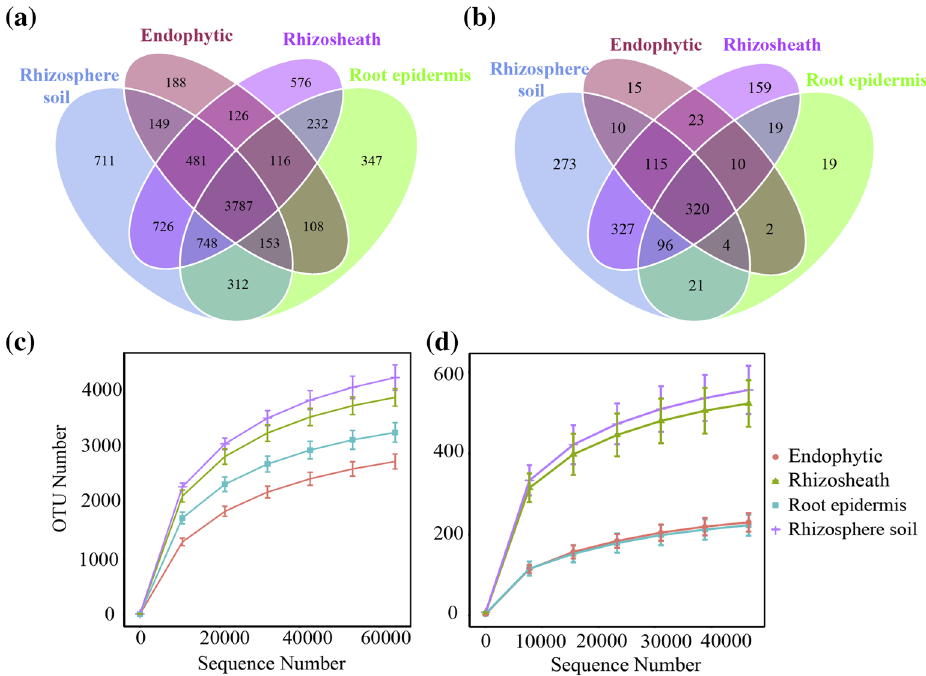
Figure 3. Venn diagrams of samples and rarefaction curves for samples. In ( a ) and ( c ) are bacteria, and ( b ) and ( d ) are fungi. In ( a , b ), each circle in the Venn diagram represents a group of samples. The numbers in the overlapping areas represent the number of OTUs shared between groups, and the numbers in areas without overlap represent the number of OTUs unique to the sample group. In ( c , d ), the abscissa is the number of sequencing pieces randomly selected from a sample, and the ordinate is the number of OTUs that can be constructed based on the number of sequencing pieces to reflect the sequencing depth.